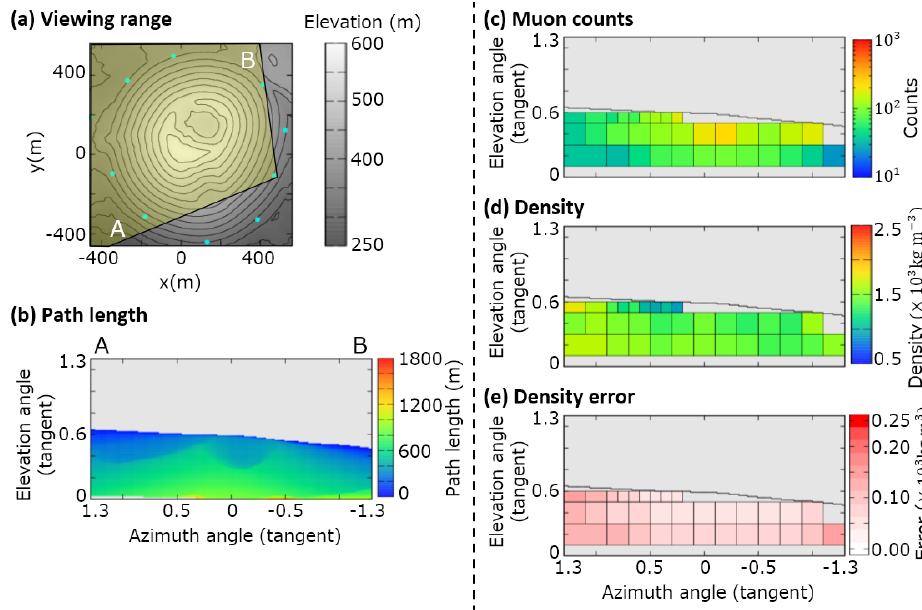
Figure B7. Observation site ESE. (a) Map, topography, and viewing range; (b) path length of the volcanic cone; (c) muon counts N obs (d) density ρ i . The maximum value of the color bar indicates a density of > 2 . 5 × 10 3 kgm − 3 and the minimum value is < 0 . 5 × 10 3 kgm − 3 .